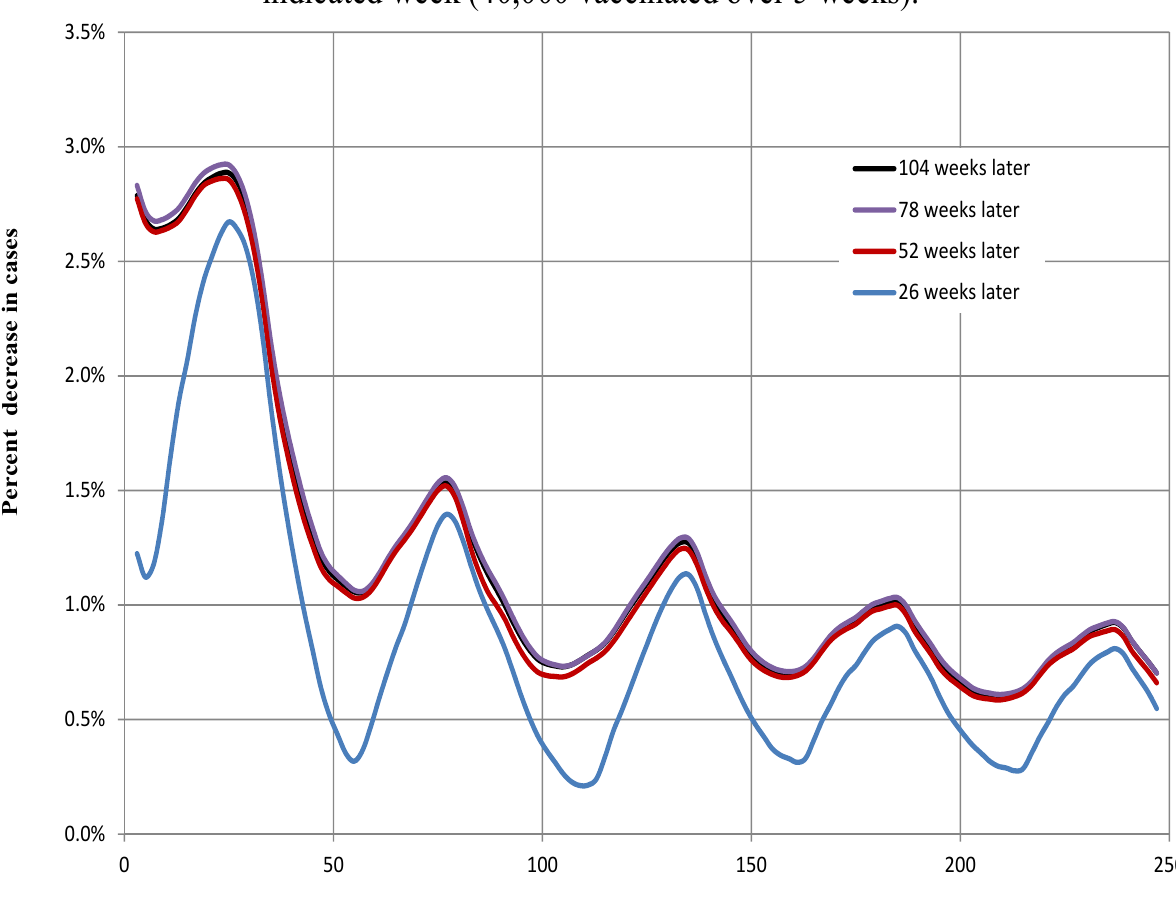
Figure 16. Artibonite. The percent decrease in the total number of cases 26, 52, 78 and 104 weeks after the beginning the second round of vaccination indicated on the abscissa. The onset of the immune response was assumed to begin a week later. We assume 70% efficacy of the